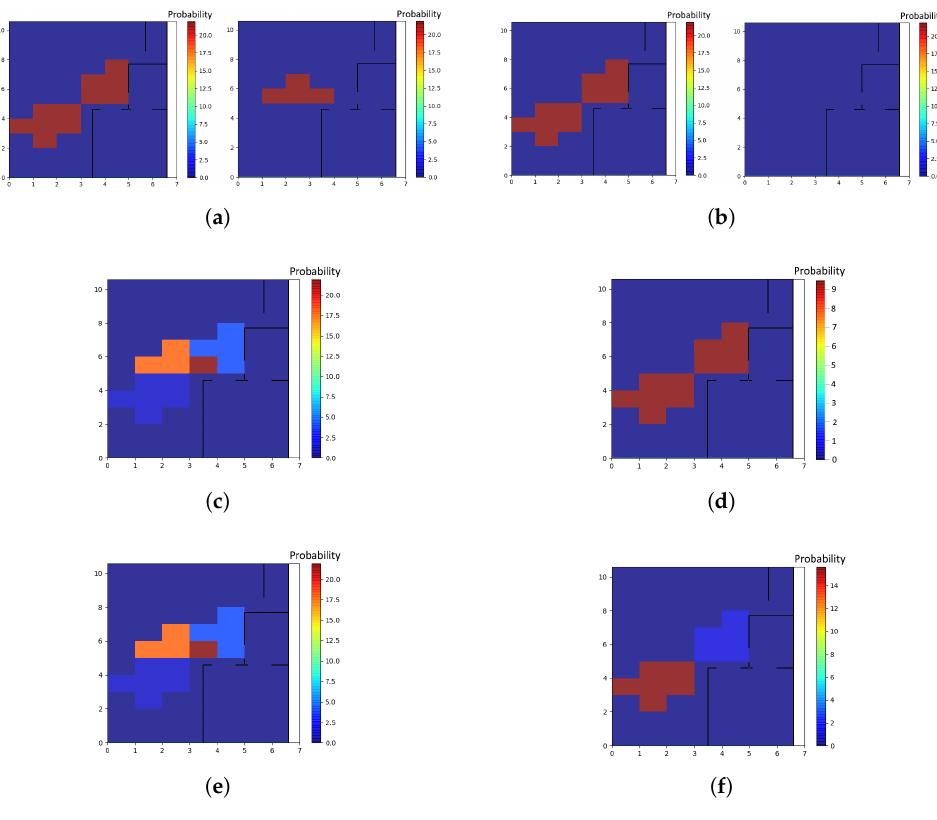
Figure 3. Confidence maps for 2 persons with motion sensors, and Estimote events for person 1 only. Figure 3a,c,e correspond to participant 1, and Figure 3b,d,f correspond to participant 2. ( a ) Initial confidence maps produced by coming out of the motion localizer ( right ) and estimote localizer ( left ) for participant 1; ( b ) Initial confidence maps produced by coming out of the motion localizer ( right ) and estimote localizer ( left ) for participant 2; ( c ) Confidence map for participant 1 after Fusion; ( d ) Confidence map for participant 2 after Fusion; ( e ) Final confidence map for participant 1; ( f ) Final confidence map for participant